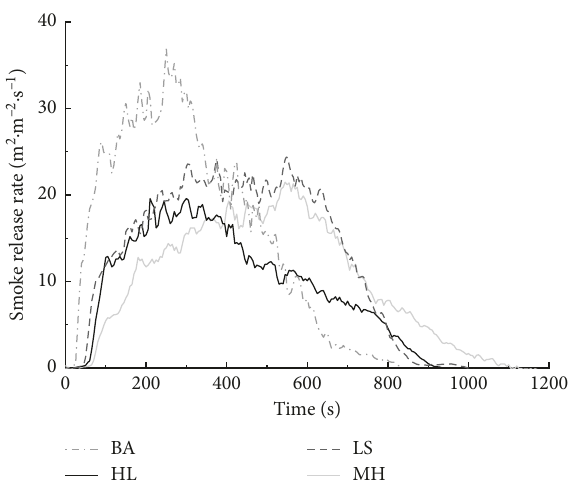
Figure 3: Weight loss curves of BA and HL.